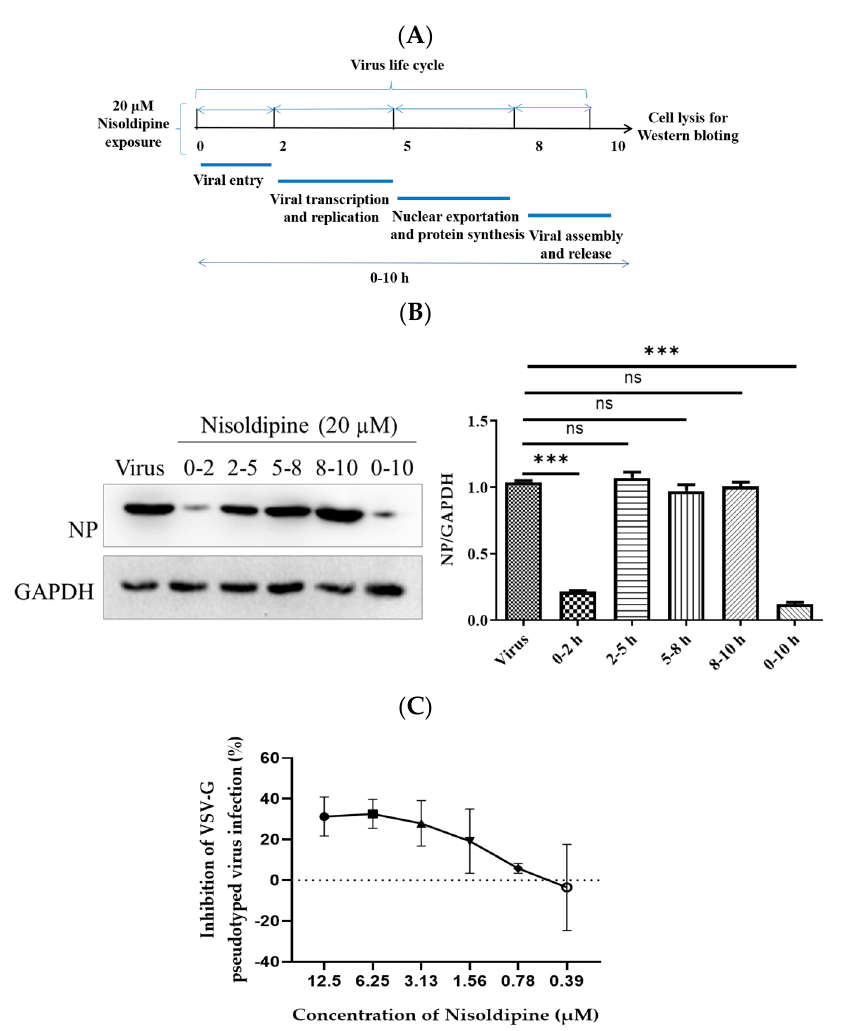
Figure 2. Nisoldipine blocked virus infection in the entry stage of IAV infection. ( A ) IAV − infected A549 cells were co − incubated with nisoldipine (20 µ M) at different time points during a single replication cycle of the influenza A virus. Cell lysates were collected at 10 h after infection. ( B ) The expression of NP and GAPDH proteins was detected by Western blotting. ( C ) The inhibitory activity of nisoldipine against VSV − G PsV infection. Data are presented as mean ± SD (*** p < 0.001); ns means not significant.